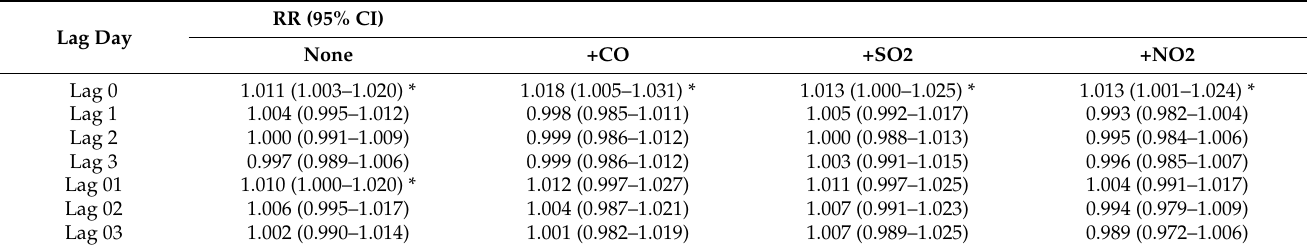
Table 2. Adjusted relative risk estimates for daily cases of AMI event (95% CI) per 10 µ g/m 3 increase in PM2.5 at single-lag (lag 0, lag 1, lag 2 and lag 3) and cumulative-lag (lag 01, lag 02 and lag 03) models a .